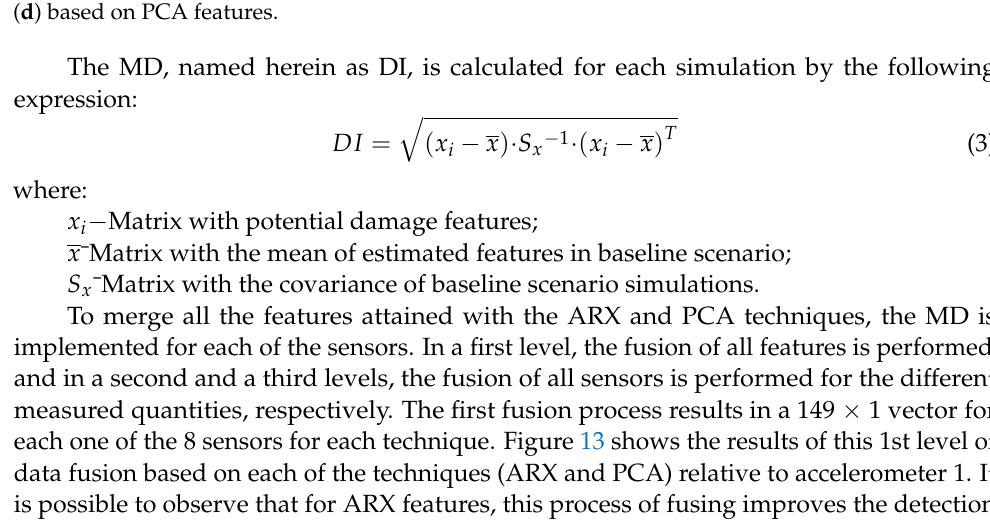
Figure 12. Feature normalization for accelerometer 1: ( a ) and ( b ) based on ARX features; ( c ) and ( d ) based on PCA features.